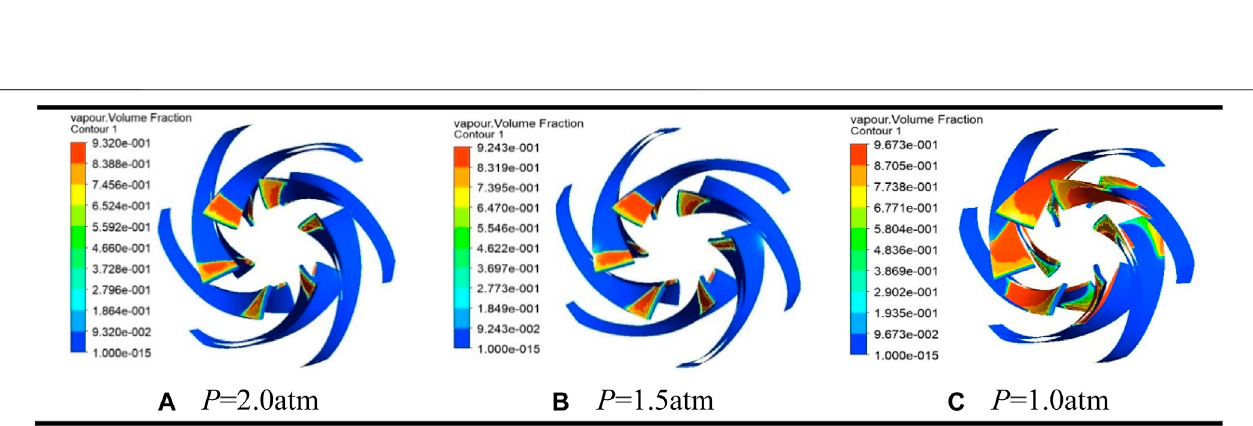
FIGURE 8 | Volume distribution of cavitation on the blade suction side. P in represents different atmospheric pressures.